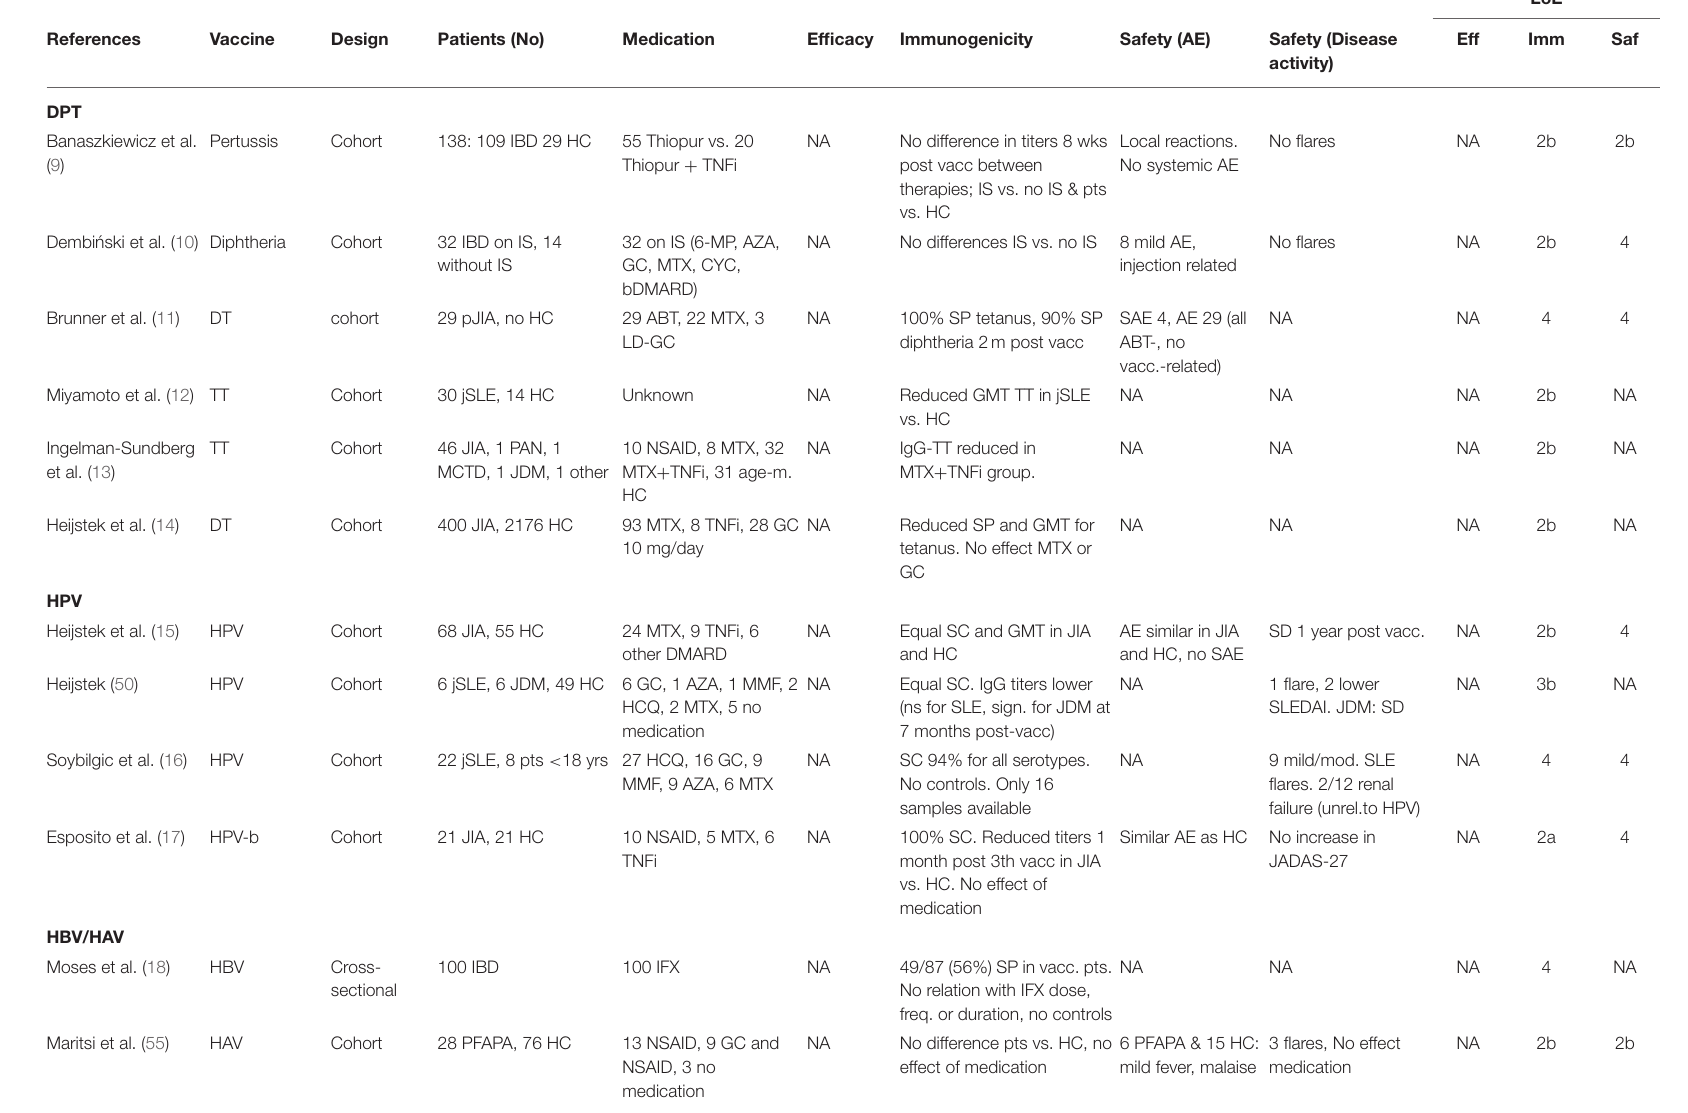
TABLE 1 | Critical appraisal of the literature on the efficacy, immunogenicity and safety of vaccinations in